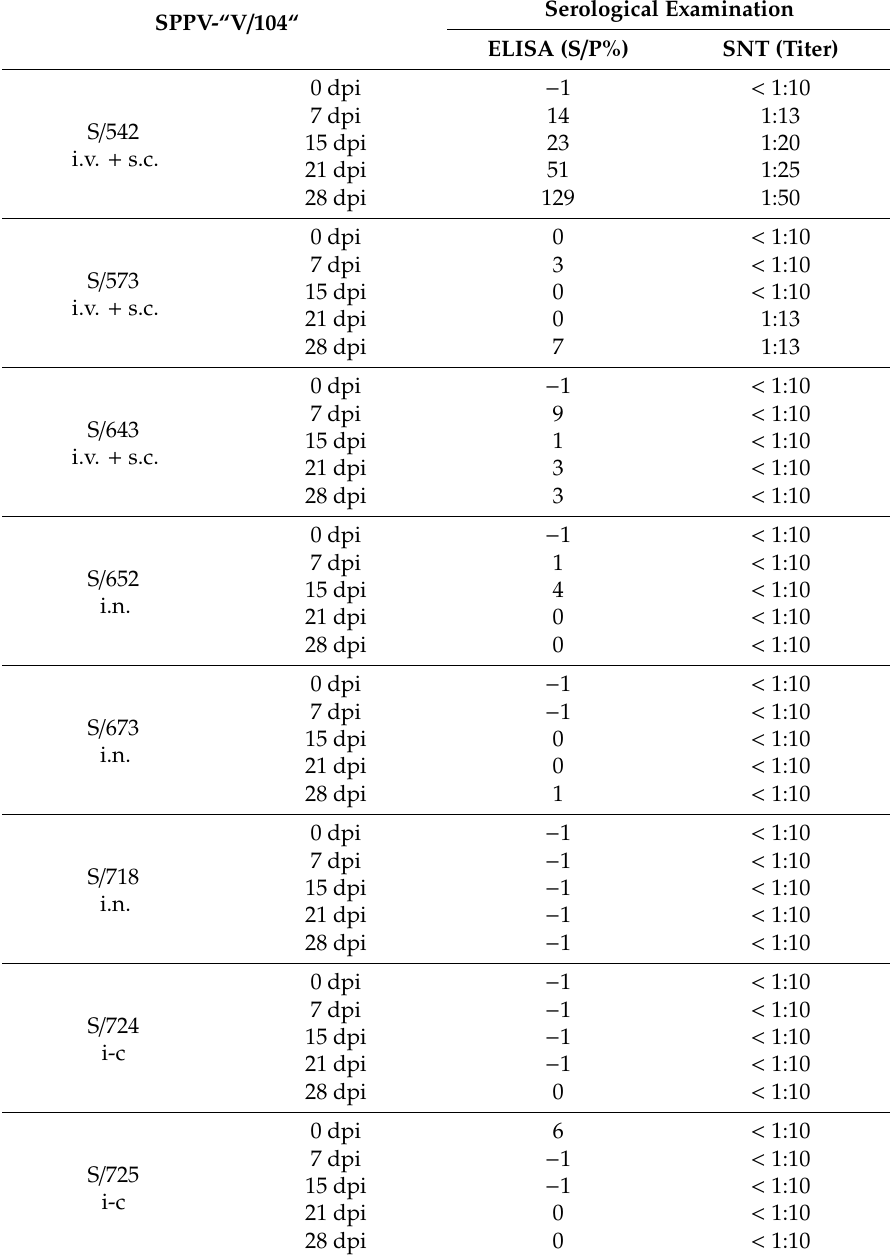
Table 4. Serological analyses of serum samples taken from sheep inoculated with SPPV-“V / 104“. For the ELISA, an S / P% of ≥ 30 was defined as positive. In the serum neutralization test (SNT), a titer ≥ 1:20 is defined